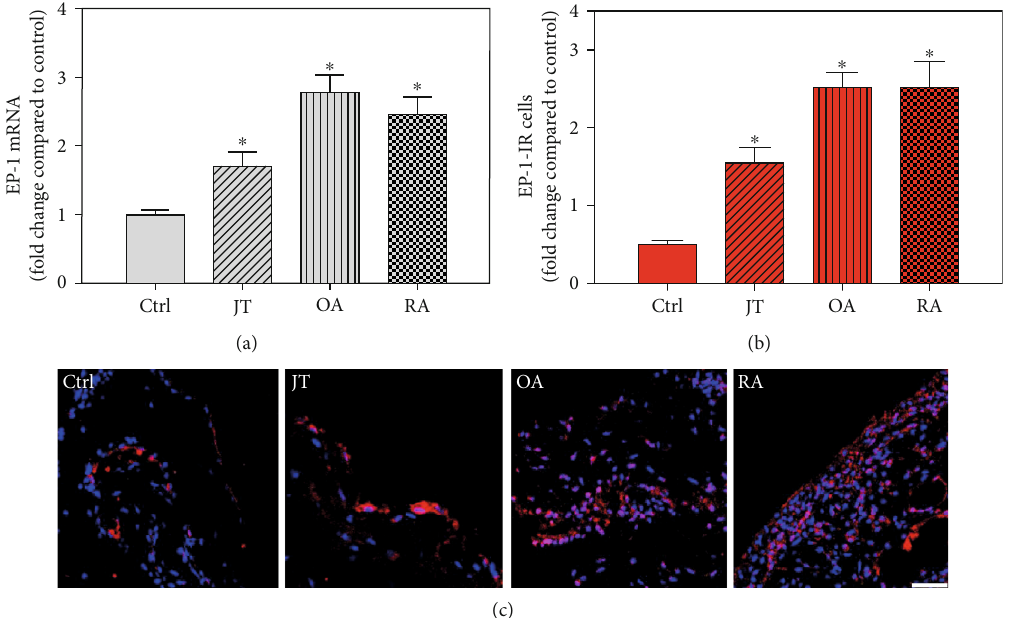
Figure 4: Detection of PGE-2 receptor 1 (EP1 receptor) mRNA (a) and number of EP1-IR cells (b, c) in patients with joint trauma (JT), osteoarthritis (OA), and rheumatoid arthritis (RA). (a) Quanti fi cation of EP1 mRNA shows that EP1 mRNA was more prominent in various forms of in fl ammatory joint disease compared to control synovium (data are shown as means ± SEM , P < 0 : 05 , one-way ANOVA followed by Tukey ’ s test). (b) Quantitative analysis of immuno fl uorescence microscopy for EP1-IR cells relative to control synovium (data are shown as means ± SEM , P < 0 : 05 , Kruskal – Wallis ANOVA on ranks followed by Dunn ’ s test). (c) Immuno fl uorescence microscopy shows more abundant EP1-IR cells (Texas red fl uorescence) in JT, OA, and RA compared to control synovium. DAPI blue fl uorescence shows nuclear staining. Bar = 20 μ m . ( ∗ P < 0 : 05 , compared to